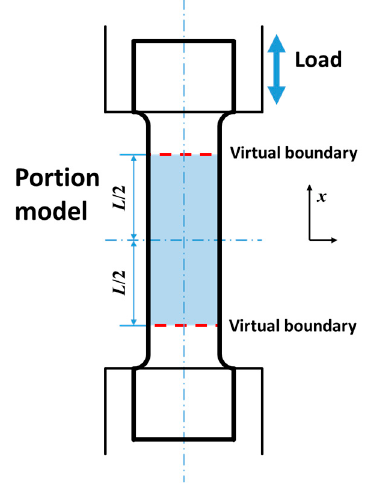
Figure 3. Schematic of the portion of the specimen for build the thermal model.